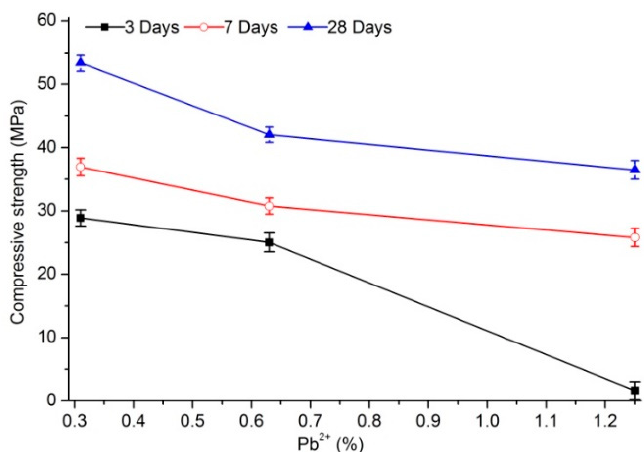
Figure 1. Compressive strength of samples cured with P • C 32.5 cement (PC).